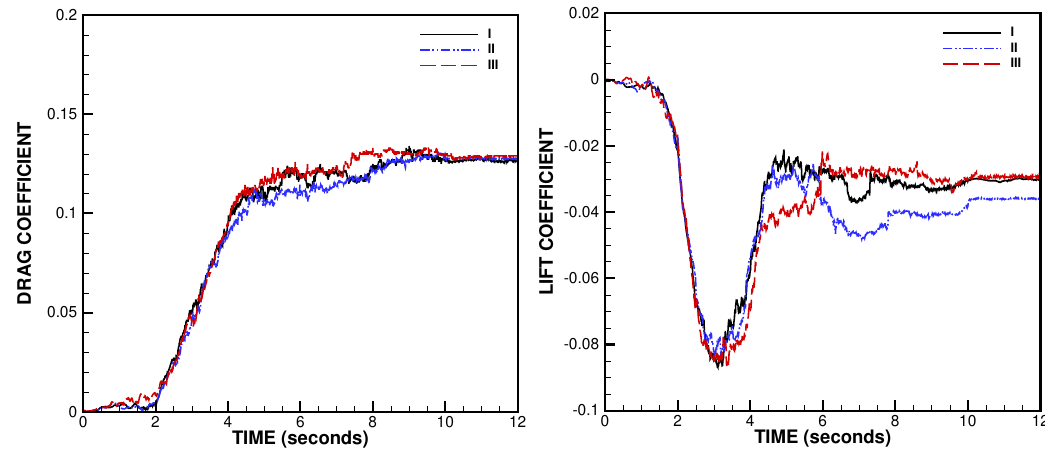
Figure 11. NLG: time history of drag and lift coefficients for the gear strut and